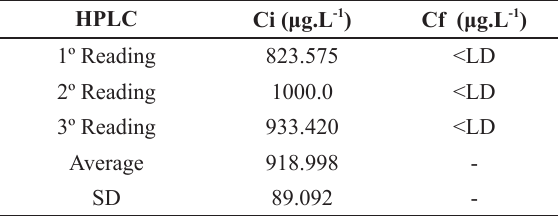
Quantitative results obtained by chromatographic analysis of individual cyproterone acetate solution before and after removal by